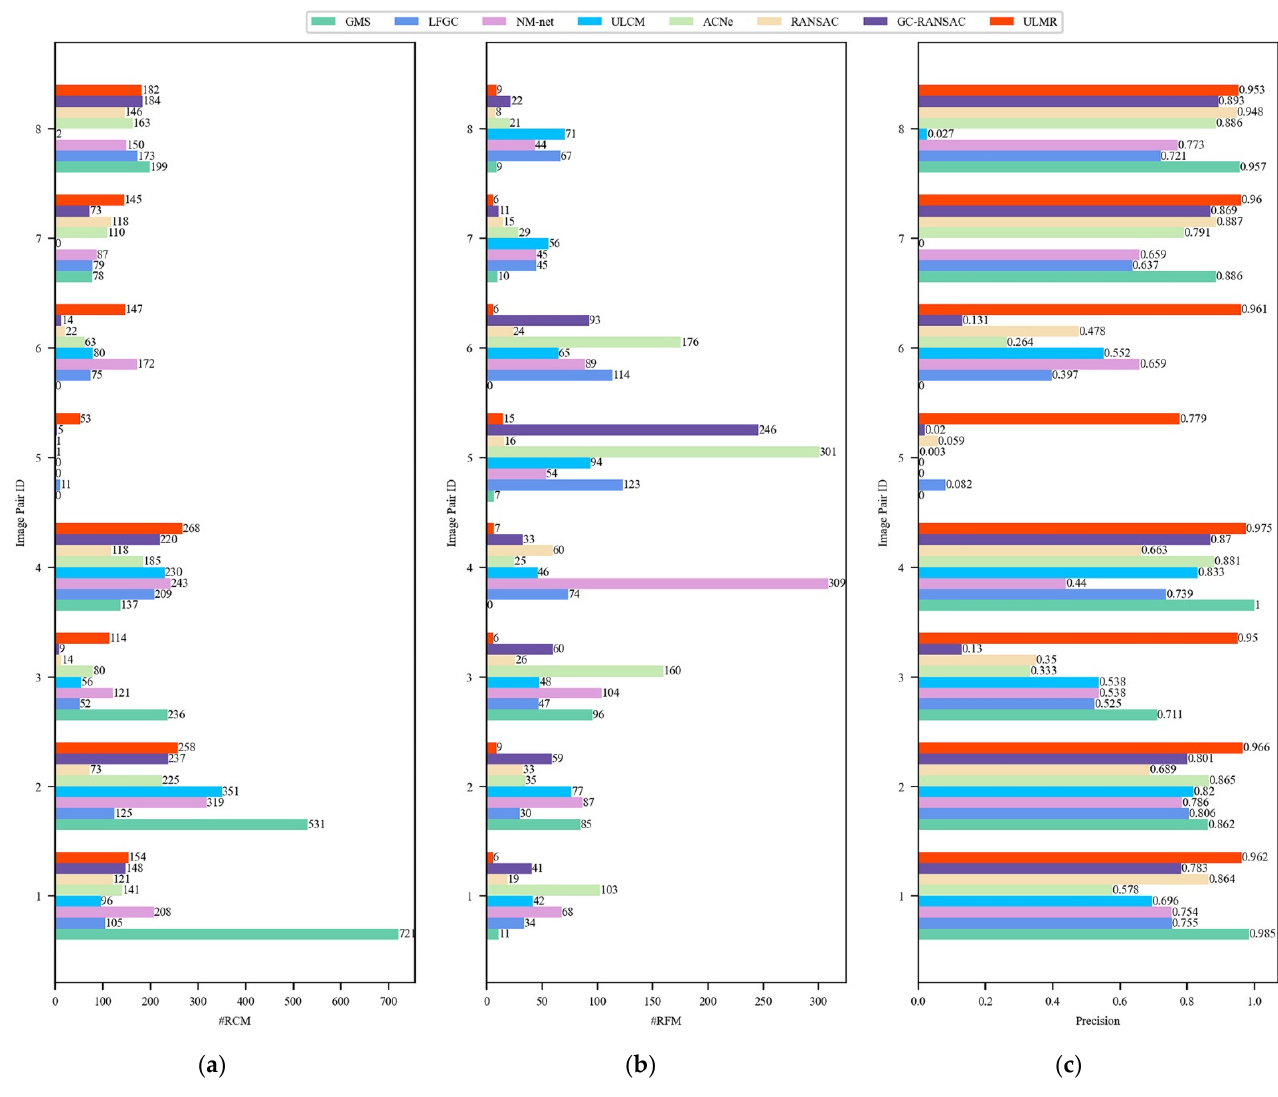
Figure 6. Quantitative mismatch removal results of real scenario images. ( a ) #Precision; ( b ) #RCM; ( c ) #RFM.